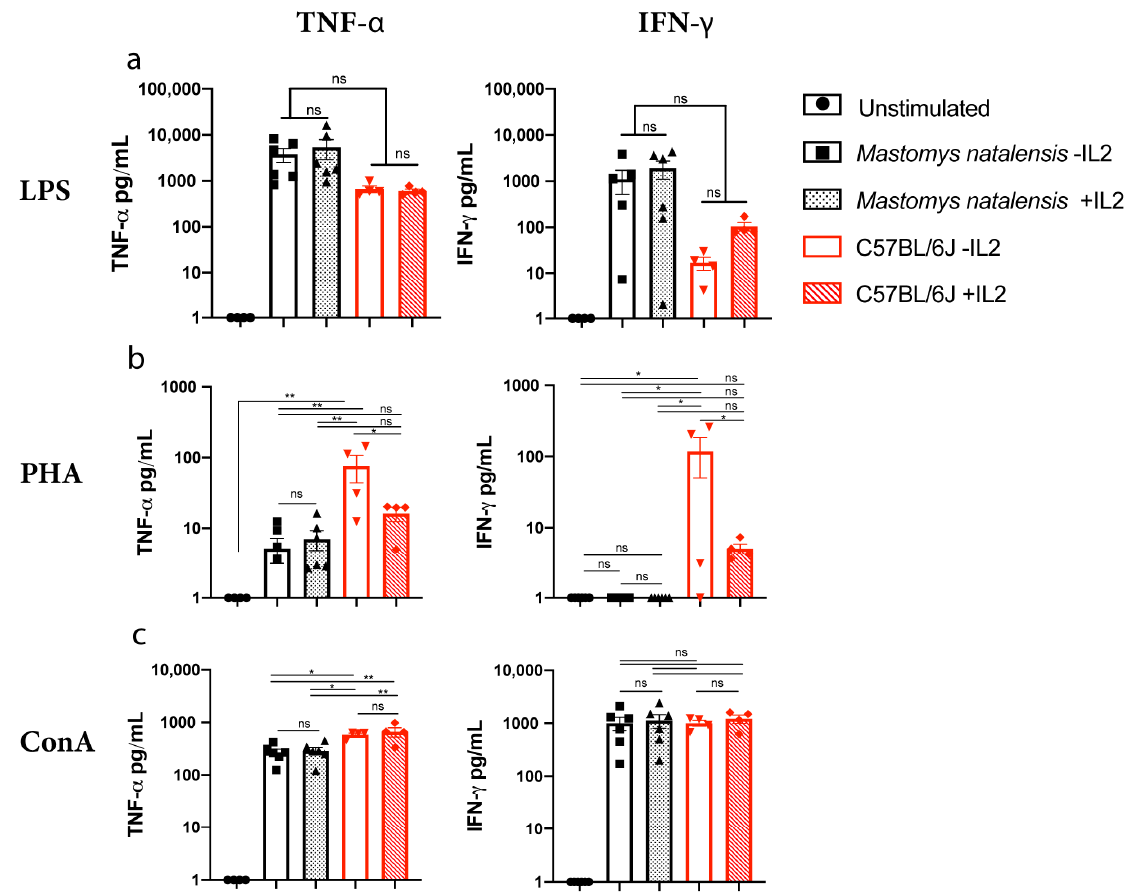
Figure 2. Secretion of effector molecules in response to stimuli. Splenic cells derived from M. natalensis (N = 6) or C57BL/6J (N = 4). Mice were stimulated with LPS ( a ), PHA ( b ), or ConA ( c ) for 24 h. Secretion of IFN- γ and TNF- α ( a – c ) were measured in the supernatants by CBA. Symbols represent individual animals. Mean ± SEM is shown. ns: not significant; * p < 0.01; ** p < 0.001; One-way